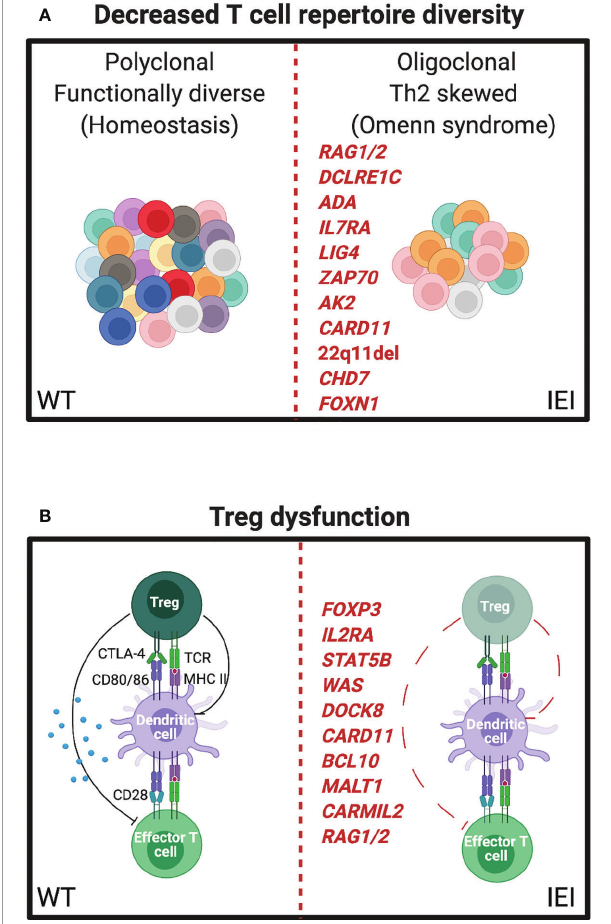
FIGURE 3 | IEI in fl uencing the T-cell repertoire can manifest as severe atopy. (A) Left, resting polyclonal T cells in a normal (WT) immune repertoire. Right, oligoclonal expansion of T cells in leaky SCID, often leading to Th2 skewing and eosinophilia (Omenn syndrome). (B) Left, normal balance between regulatory T cell (Treg) and effector T cell (Teff) functions. Right, mutations affecting Treg number or function leading to autoimmune and atopic